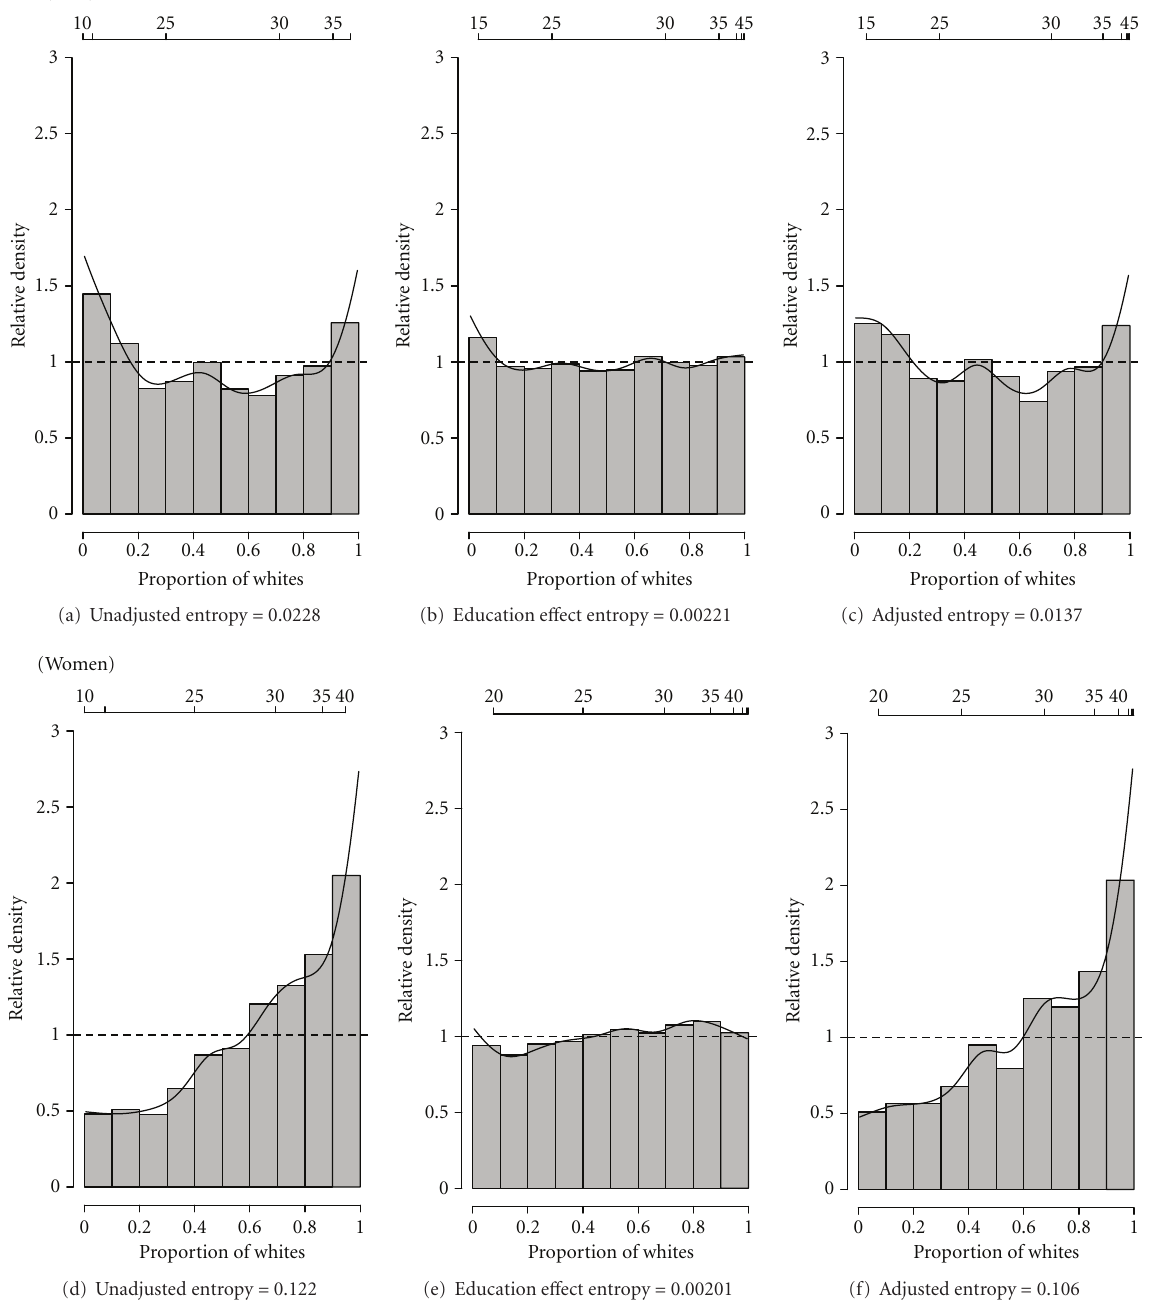
Figure 4: Relative body mass index distributions (1999–2006) between non-Hispanic black and white men (top) and women (bottom) adjusted for changes in the education composition between non-Hispanic Blacks and non-Hispanic Whites: (a,d) Unadjusted relative body mass index density; (b,e) e ff ect of changes in the education composition between non-Hispanic blacks and whites; (c,f) education-adjusted relative body massindex density. Deciles chart superimposed on relative densities. Data from the NationalHealth and Nutrition Examination Survey. Panel (a, d) represents the unadjusted relative BMI density (same as in Figure 2(a, d)). The composition e ff ect in panel (b, e) represents the BMI distribution that would have occurred if only the education profile of non-Hispanic Whites had changed (i.e., it represents the e ff ect of changes in the marginal distribution of education). Panel (c,